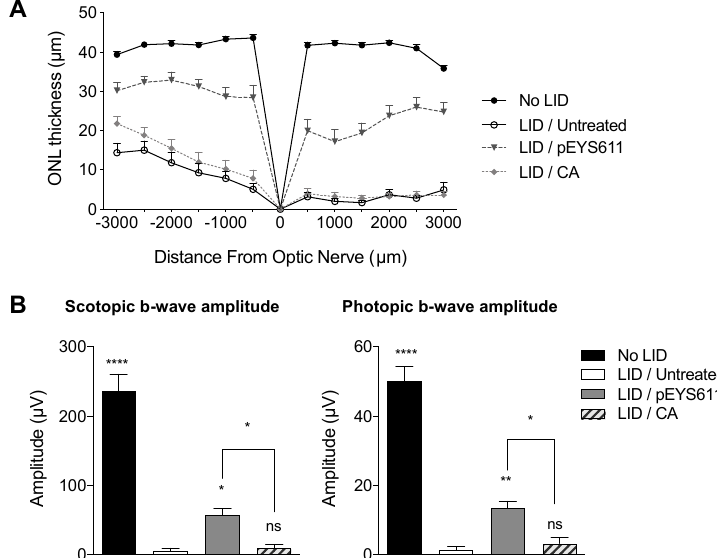
Figure 7. pEYS611 shows benefit over the antioxidant in the rat LID model. Rats received a single ciliary muscle electrotransfection of pEYS611 (30 µ g / eye) on D-3 or daily administration of CA (25 mg / kg / day) from D-5 to D0 ( n = 8 animals / group). Except for unexposed animals (no LID), retinal degeneration was induced on D0 by 24 h of bright light exposure (6500 lux). Dark- and light-adapted ERG responses were recorded simultaneously from both eyes on D8. Following ERG recordings, animals were sacrificed for histological examinations. ( A ) ONL thickness was measured every 500 µ m from the optic nerve (0) to the inferior ( − ) and superior ( + ) poles of the retina, values are presented as mean ± sem. ( B ) Amplitude ( µ V) of b-waves from ERG responses elicited by a stimulus intensity of 3 cd · s / m 2 (left) and of 10 cd · s / m 2 (right) are presented as mean ± sem. * p < 0.05; ** p < 0.01; **** p < 0.0001 using repeated measure mixed model versus LID / untreated group.